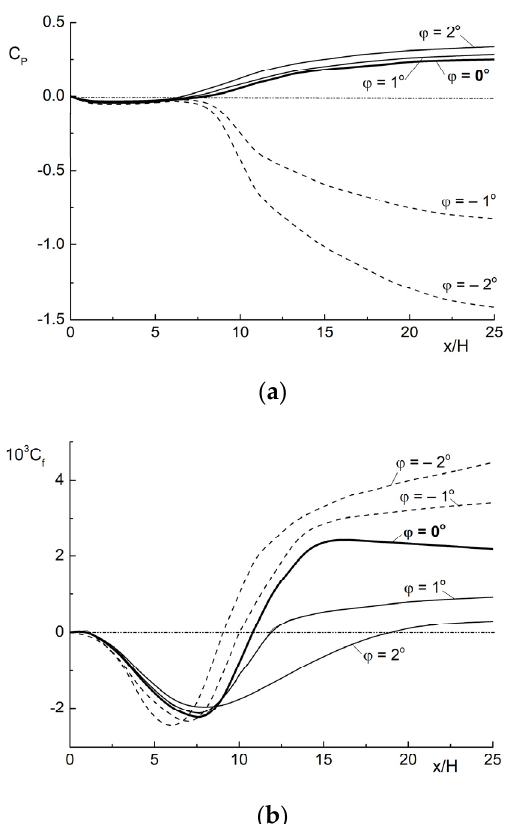
Figure 3. The evolution of pressure C P ( a ) and wall friction C f ( b ) coefficients along the axial coordinates in ZPG ( φ = 0°), diffuser ( φ > 0°, APG), and confuser ( φ < 0°, FPG). M L 1 = 0.05, d 1 = 30 μ m.